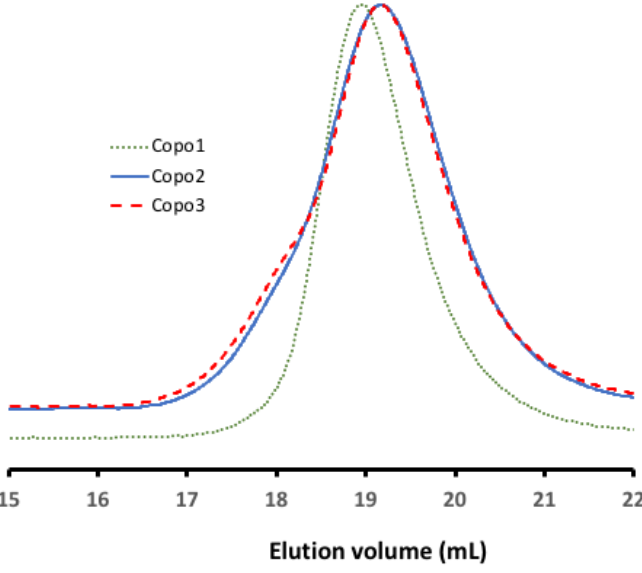
Figure 4. Evolution of SEC profiles of copolymers.